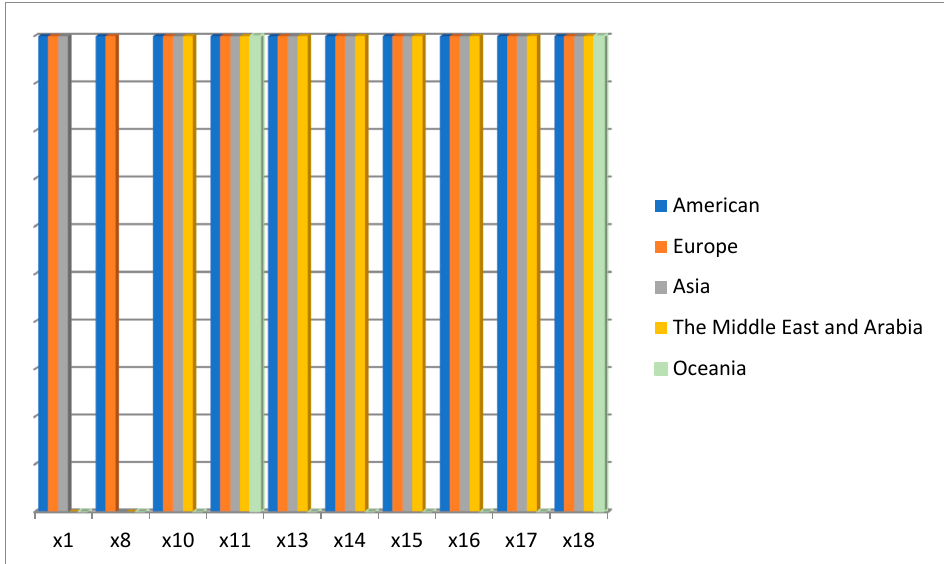
Figure 6. Dendrogram for offices during January2019 using single linkage clustering algorithm when N = 8 (scenario II).